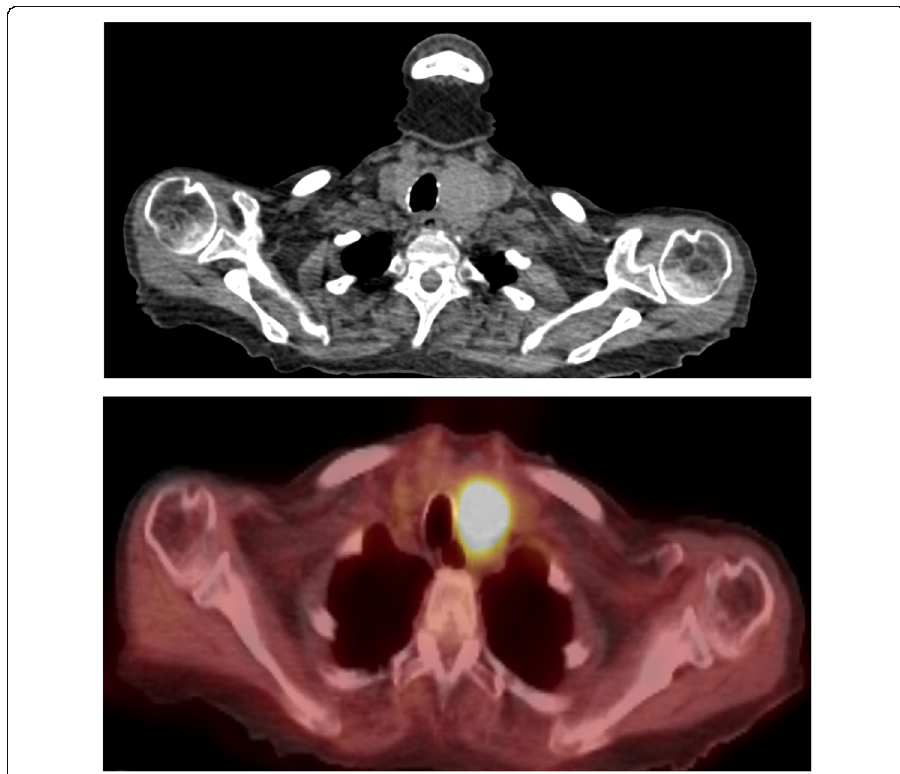
Fig. 2 Seventy-nine-year-old female with a past medical history of systemic sclerosis and Raynaud ’ s disease. She presented with symptoms of weight loss, retrosternal chest discomfort and general cognitive decline. Prior investigations had shown a raised CRP and normal WCC in her routine blood, and an OGD showed oesophagitis only. She had a CT CAP and PET-CT to investigate for possibility of an organ tumour/large vessel vasculitis. Image a shows axial CT with a large left-sided thyroid mass. Image b is a fused axial PET-CT scan showing 33mm × 36mm metabolically active lesion (SUV max 10.3g/ml) which occupies much of the left lobe of the thyroid gland and is responsible for tracheal deviation to the right. FNAC confirmed follicular